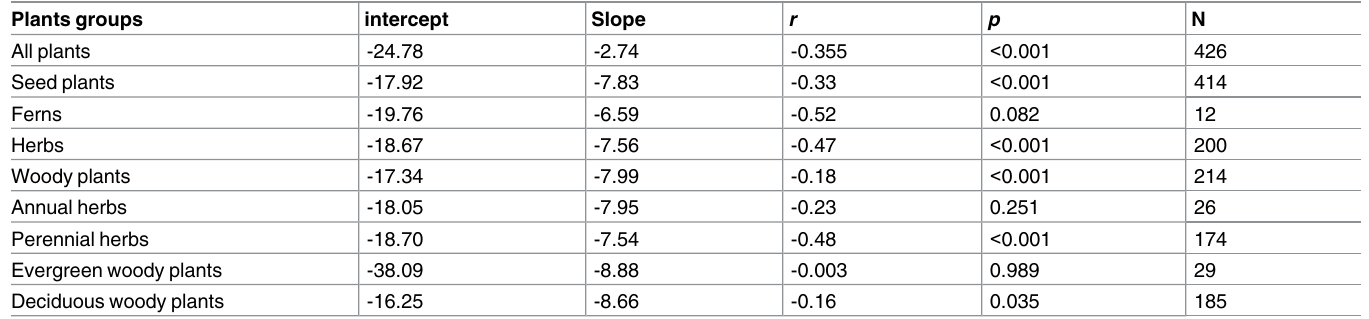
Table 1. Results of reduced major axis regressions of N mass vs. δ 13 C for different plant